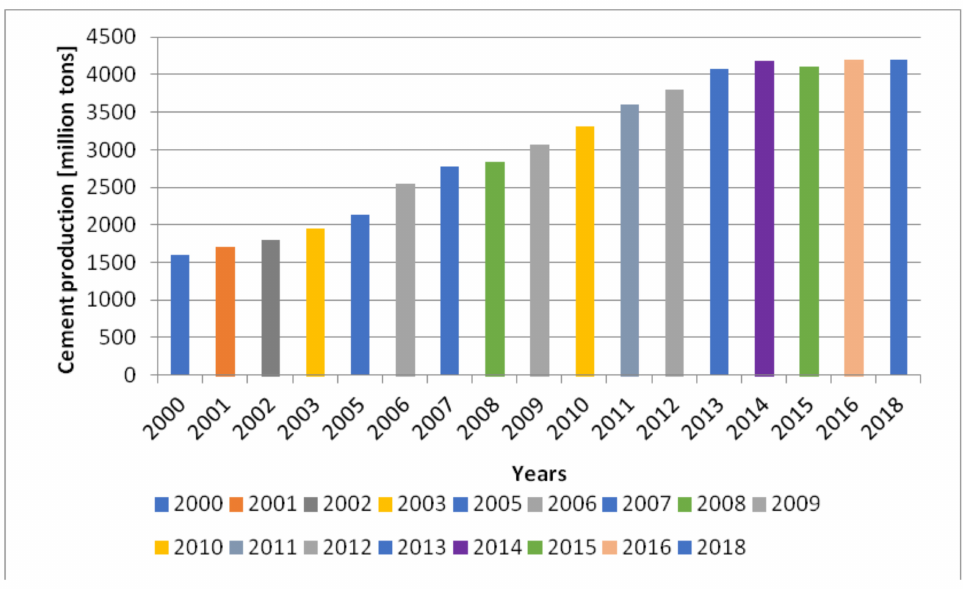
Figure 1. Global cement production in the years 2000–2018